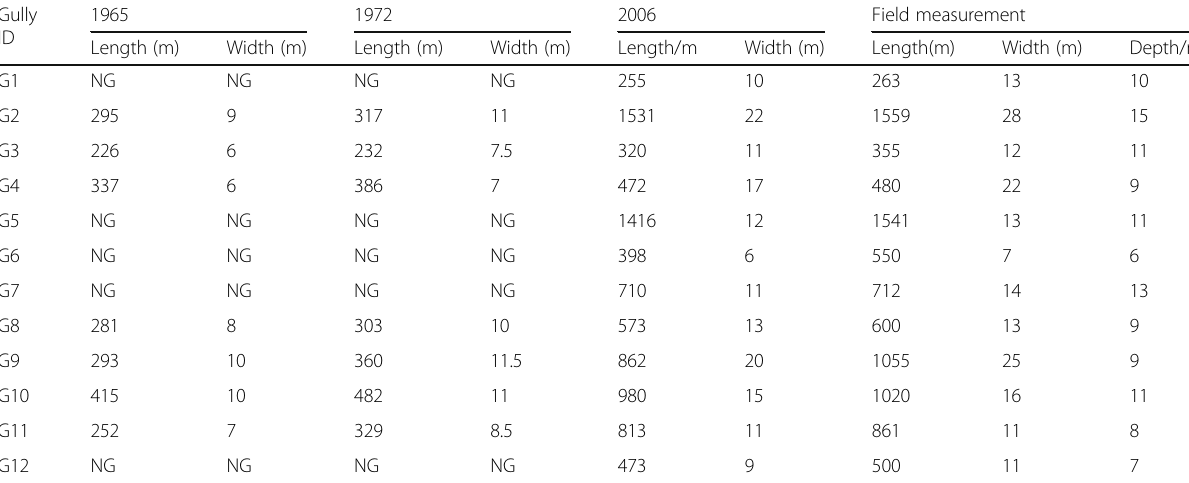
Table 4 Size of gully length, and width from 1965-2012